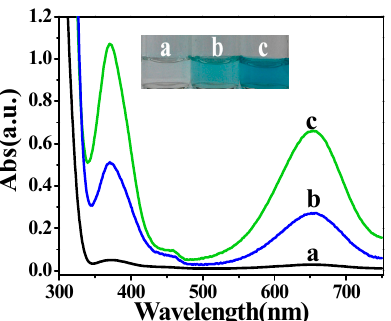
Figure 2. The UV/Vis spectra of ( a ) CdS + TMB; ( b ) CdS + TMB under visible-light irradiation; ( c ) PO 43 − -capped CdS QDs + TMB under visible-light irradiation. CdS QDs were formed in the presence of GOx (20 mg/L), 1-thio- β - D -glucose (1 mM) and Cd 2+ (1.5 mM), pH = 4.0. Irradiation time: 12 min. Inset image is the corresponding color of the above solutions.